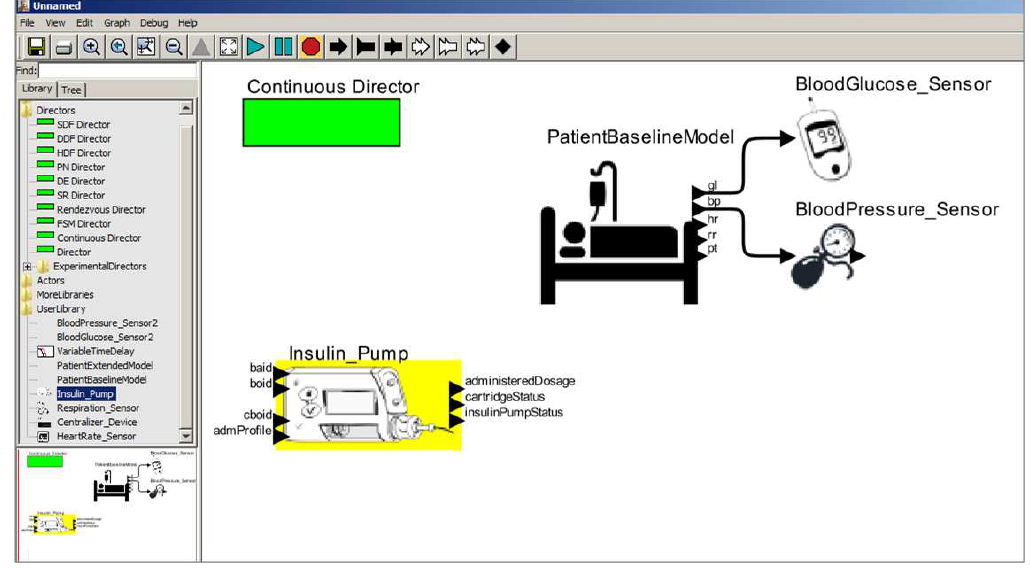
Figure 17. Defining an MCPS Model in the Ptolemy